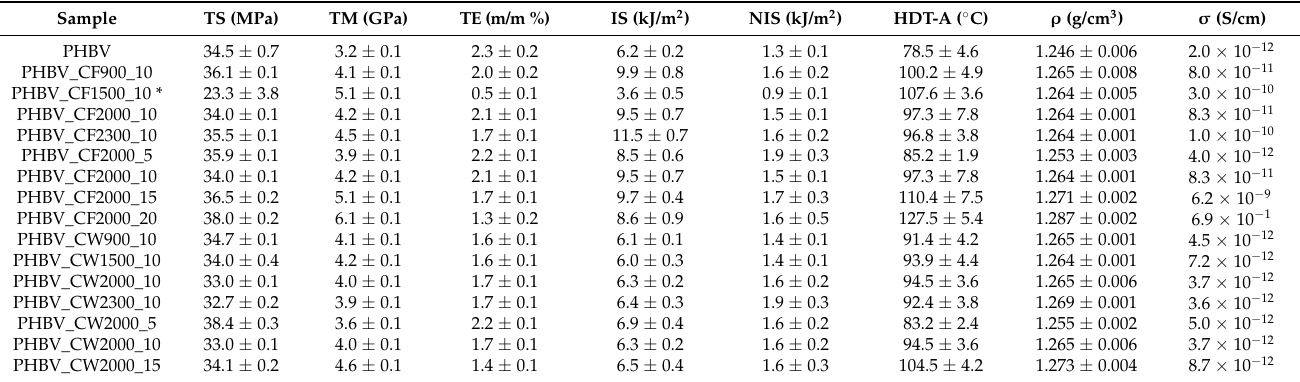
Table 4. Properties of PHBV/carbon composites including 95% confidence intervals. Tensile strength (TS), modulus (TM) and elongation at break (TE), impact strength (IS), notched impact strength (NIS), heat deflection temperature (HDT-A), density ( ρ ) and electrical conductivity at 50 Hz ( σ